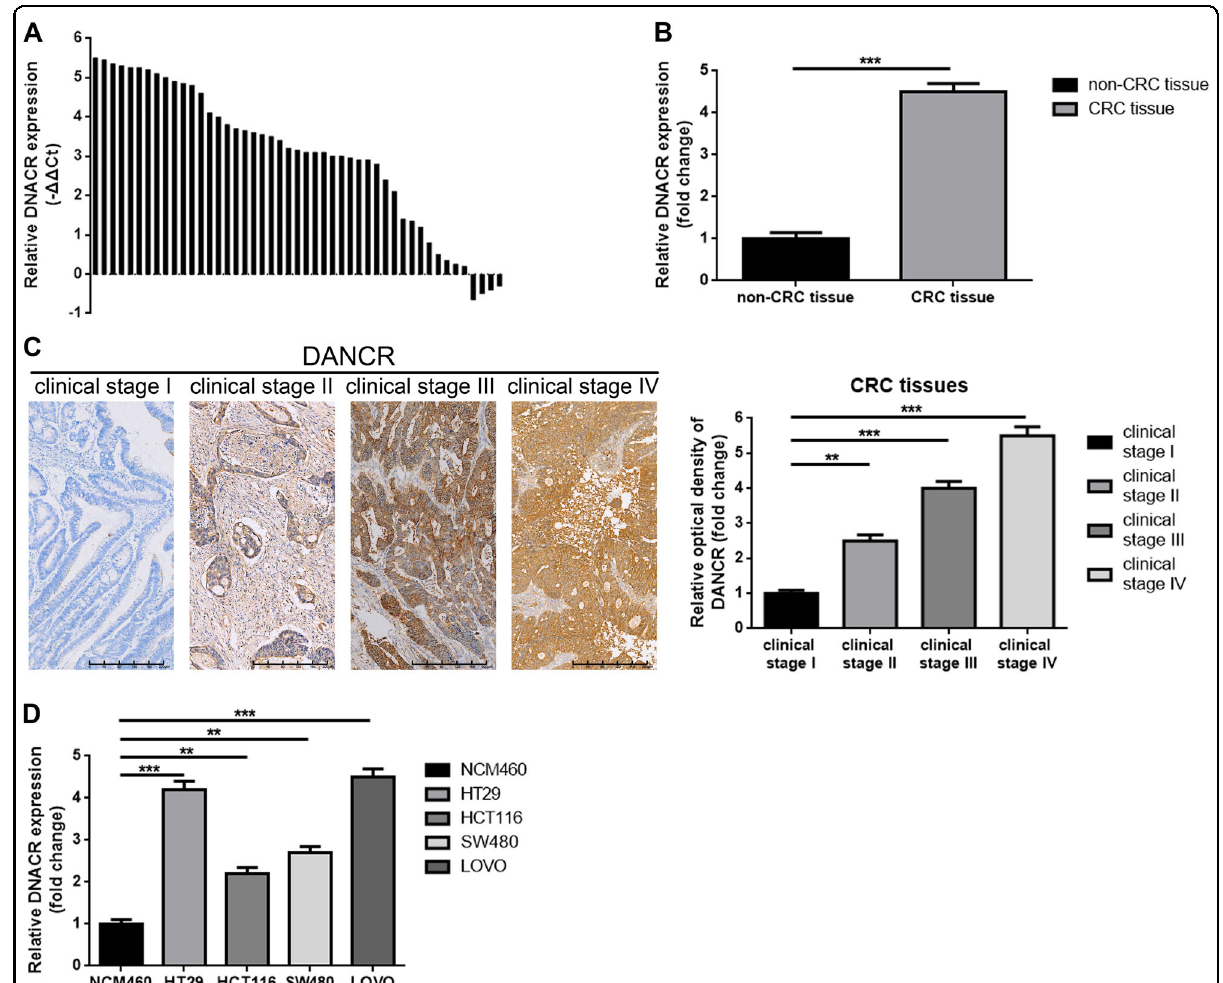
Fig. 1 Elevated DANCR is expressed in colorectal cancer tissues and cell lines. a , b DANCR endogenous expression levels were elevated in 91.49% (43/47) of CRC tissue specimens compared with those in matched non-CRC tissue specimens, as determined by qRT-PCR using GAPDH as the normalization control. ** P < 0.01 vs. the non-CRC group. c The mean optical densities of DANCR were gradually elevated according to the grading of different clinical stages of CRC tissue specimens, as detected by in situ hybridization, normalized to the clinical stage I group. ** P < 0.01, *** P < 0.001 vs. clinical stage I. d Endogenous expression of DANCR was up-regulated in the CRC cell lines HT29, HCT116, SW480, and LOVO compared with that in the normal human colon epithelial cell line NCM460, as measured by qRT-PCR using GAPDH as the normalization control. ** P < 0.01, *** P < 0.001 vs. NCM460 group. The data are shown as the means ± SD from three independent